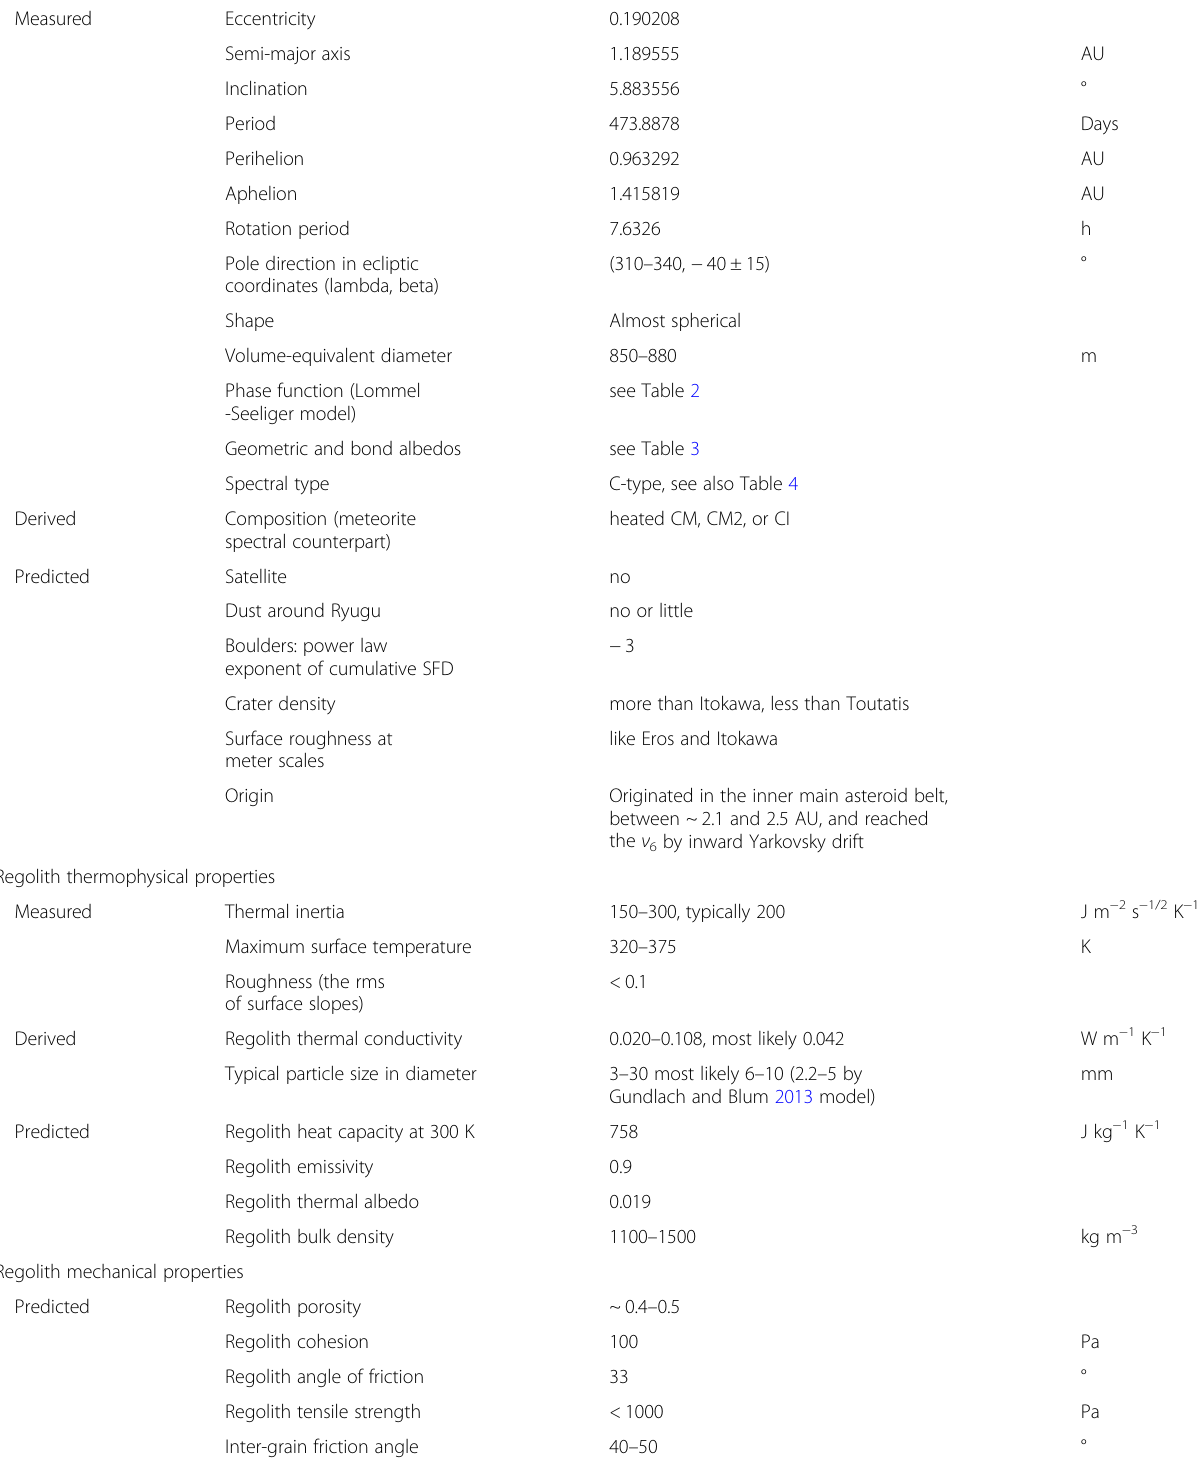
Table 8 Properties of Ryugu, covered and discussed in the text Global